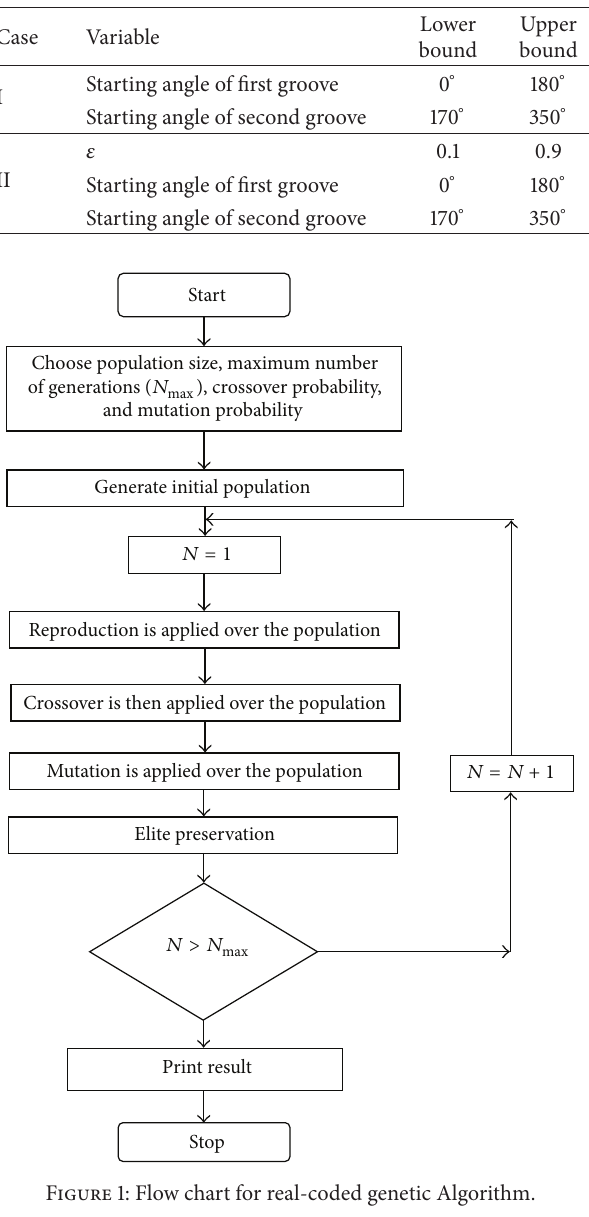
Table 1: Variable bounds for the bearing problem.